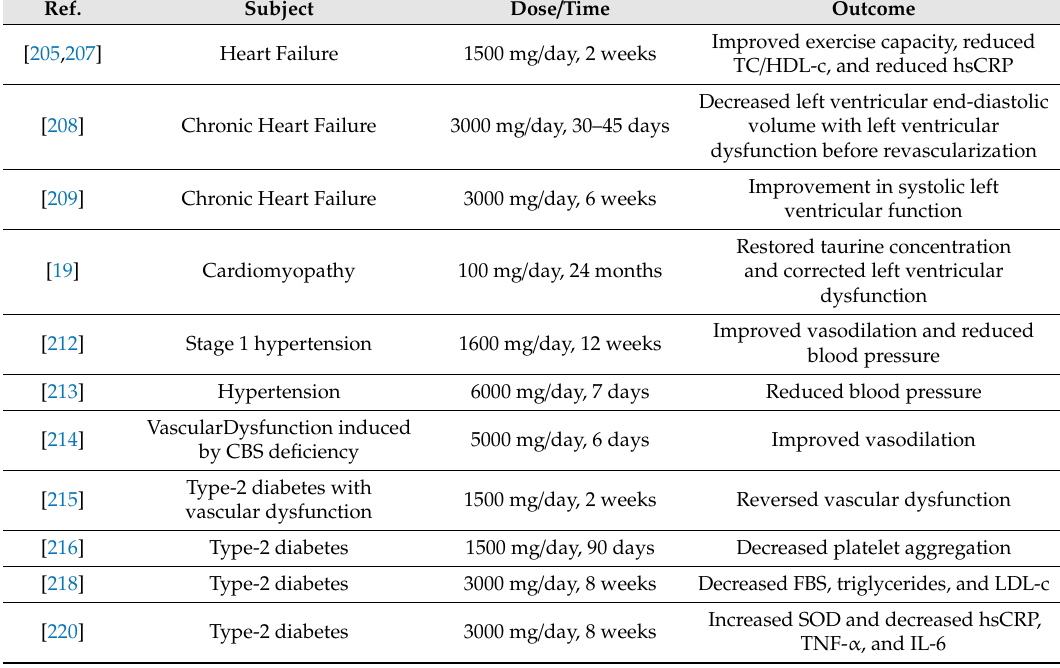
Table 1. Highlighted studies on taurine implications for beneficial e ff ects to CVD.